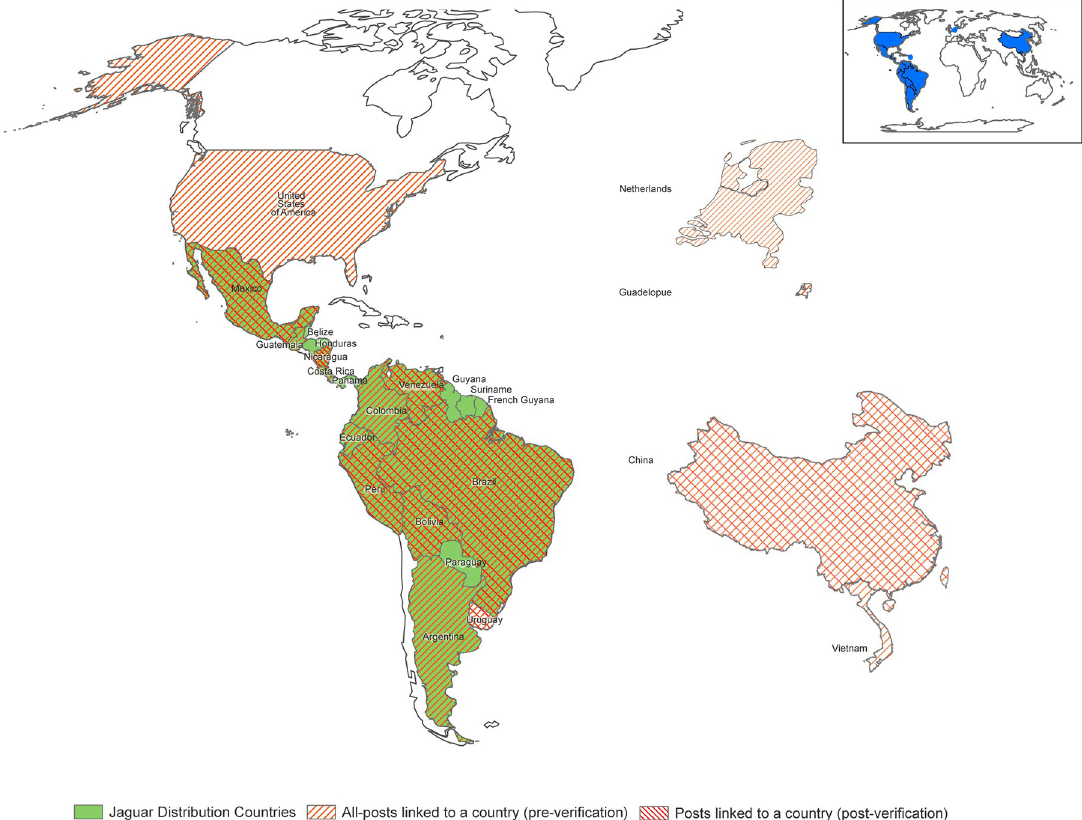
Fig 2. Map of jaguar range, all countries with posts with jaguar parts, and countries with images in posts verified as jaguar parts.